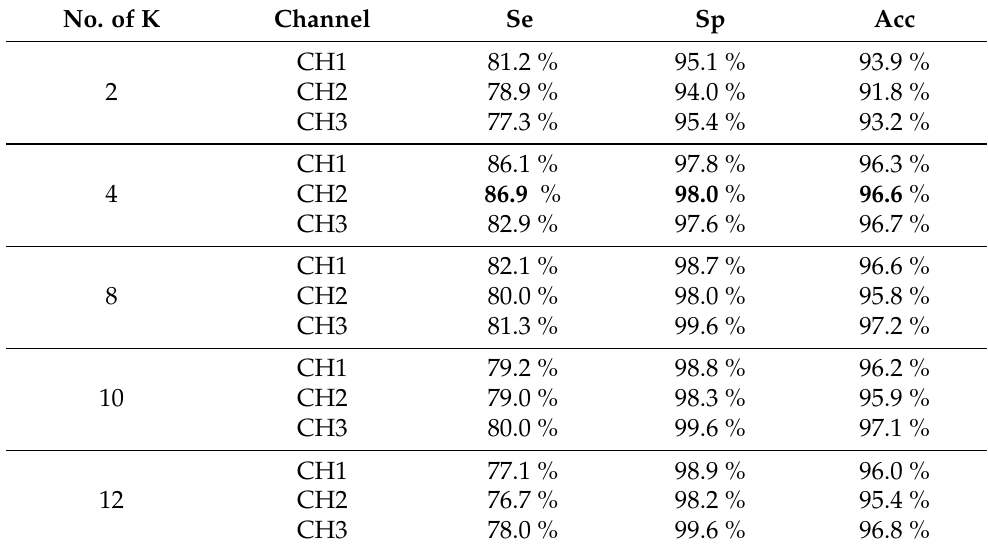
Table 1. kNN performance for different channel configurations. The best obtained results are in bold. No. of